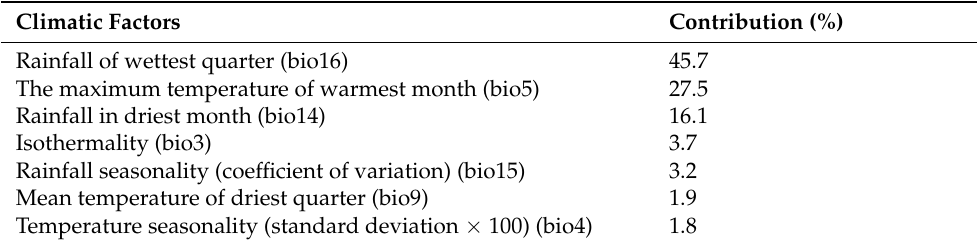
Table 1. Contributions of the climatic factors to the model of